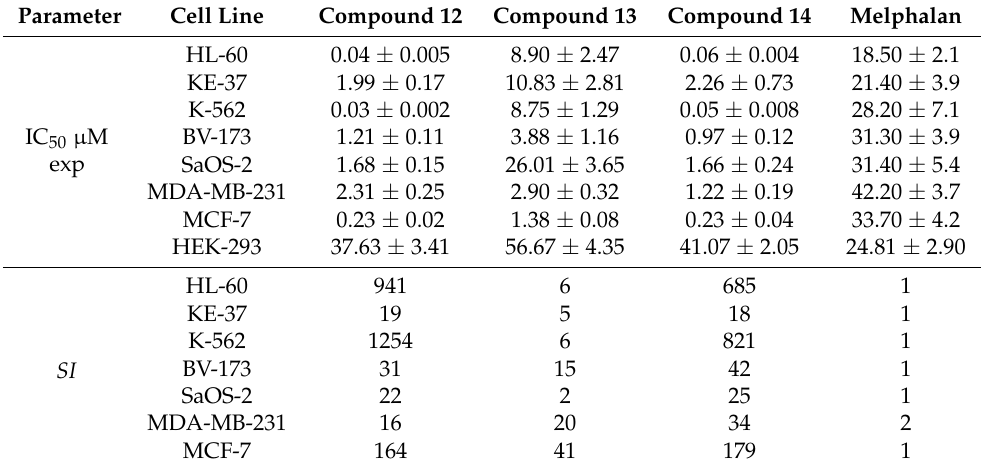
Table 4. Experimental IC 50 values in µ M and selectivity indices ( SI ) for cytotoxic activities of 4- metoxysalicylic hydrazones after 72 h